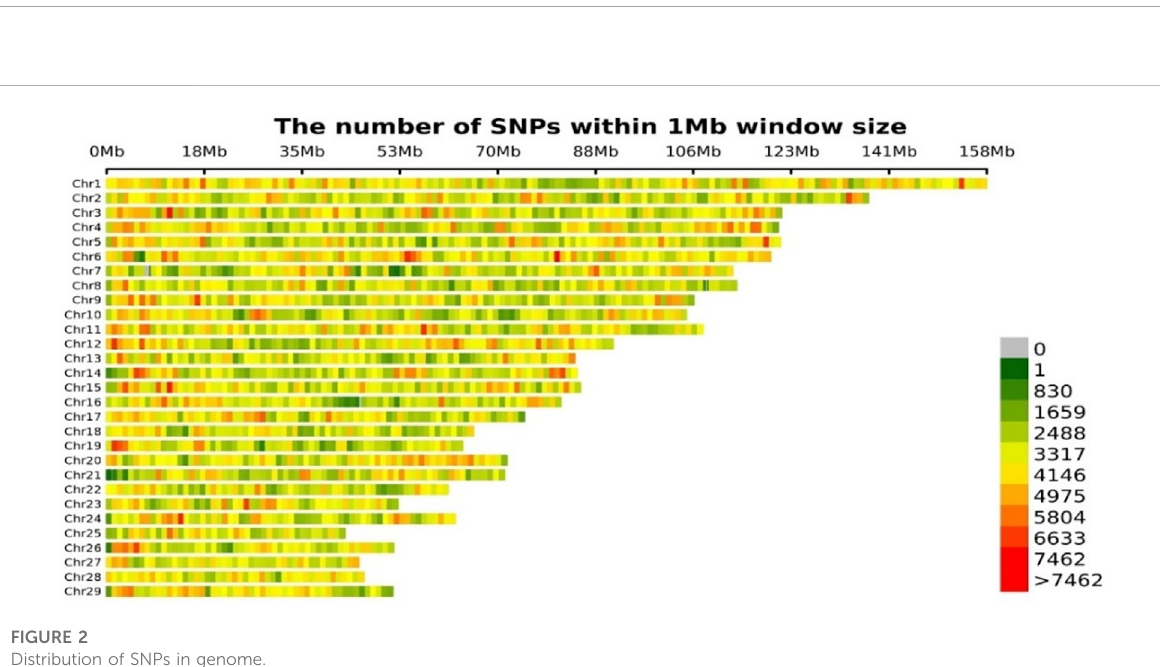
FIGURE 1 Heritabilities for milk yield, fat yield, protein yield, fat percentage, protein percentage, and SCS estimated with the random regression model for DIM.